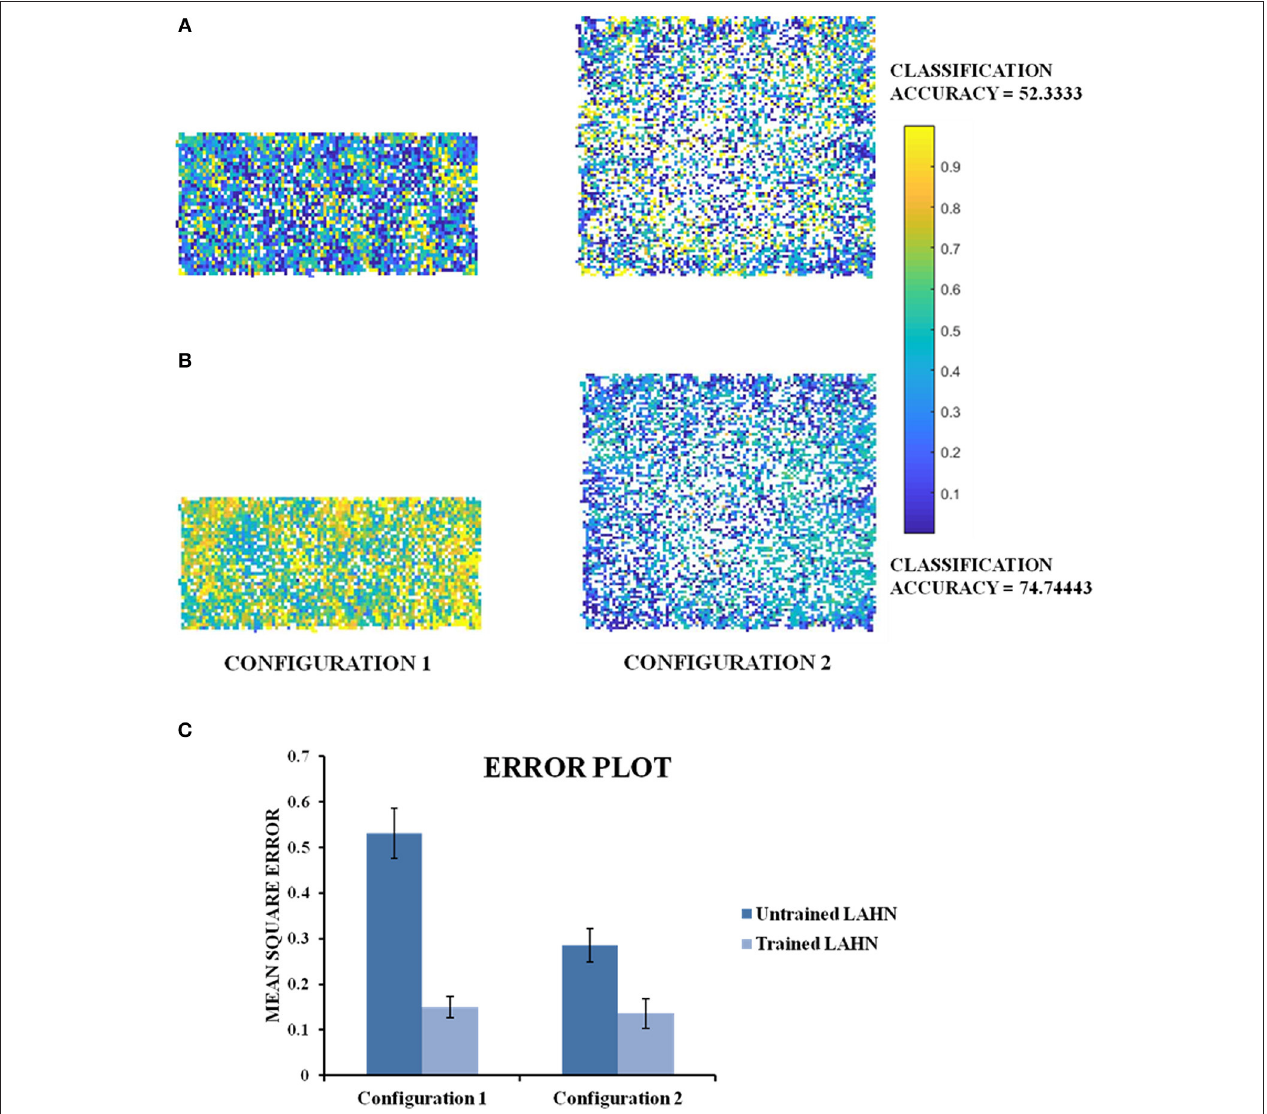
FIGURE 12 | Classification maps of the MLP output. (A) MLP classification maps using initial training periods of LAHN as input. It gives a classification accuracy of 52.33% (B) MLP classification maps using fully trained LAHN as input. It gives a classification accuracy of 74.74%.Yellow and dark blue denote configuration 1 and configuration 2, respectively. The intermediate color gradient represents output of the network activity between 0 and 1. (C) Mean Square Error of the MLP network